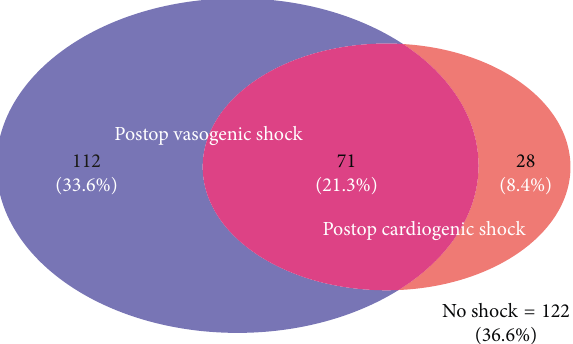
Figure 2: Diagram detailing the number and proportion of 211 patients with postoperative isolated vasogenic (blue), isolated cardiogenic shock (pink) and both shocks (purple). Of the 333 patient cohorts, 122 patients had no postoperative